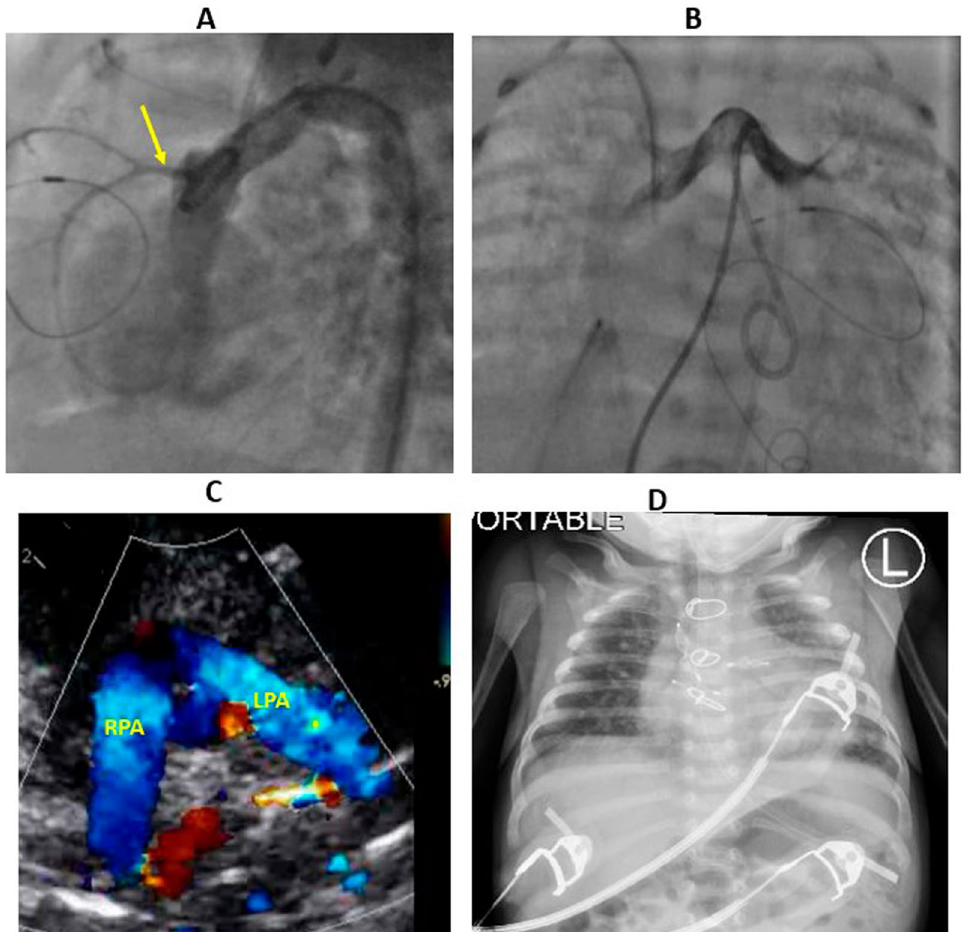
Fig. 2 Roentgenogram, angiography, and echocardiography after ASO. A aortic angiography showing normal right coronary artery (yellow arrow). B Pulmonary angiography showing patent pulmonary arteries. C Parasternal short axis echocardiographic view showing the Lecompte with patent pulmonary arteries. D chest X‑ray is done after successful closure of MAPCAs, showing improvement of pulmonary edema and skin edema. ASO: arterial switch operation, MAPCAs: Major aortopulmonary collateral arteries. RPA right pulmonary artery, LPA left pulmonary